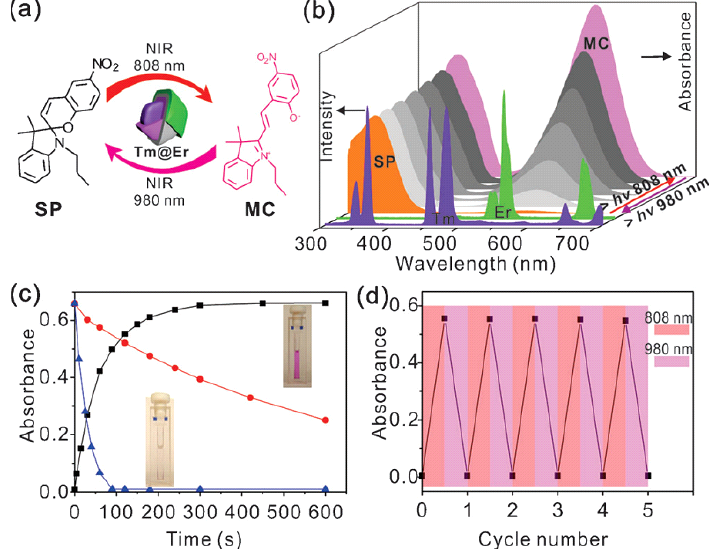
Figure 7. ( a ) Illustration of two-way photoswitching of spiropyran by using UCNPs with dual NIR excitations. ( b ) Tm 3+ and Er 3+ emissions from the UCNPs under 808 nm and 980 nm excitations and the evolution of the UV-vis absorption spectrum of the photoisomerization. ( c ) Kinetic monitoring of the photoswitching reaction. The red line shows the kinetics of the reaction of merocyanine to spiropyran. ( d ) Dual NIR-driven photoswitching of spiropyran over many cycles in THF/methanol (9/1, v / v ) solution by monitoring the absorbance of merocyanine at 560 nm. Reproduced with permission from [28]. Copyright John Wiley & Sons,